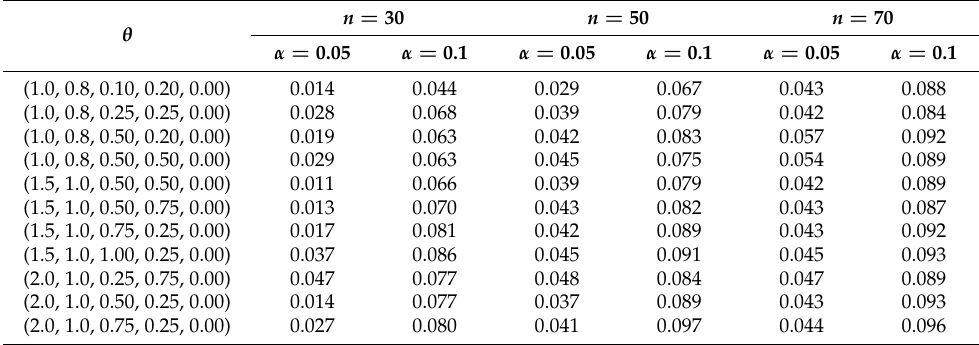
Table 3. Simulation results for the probability of type I error for a 1 = 0 and a 2 = 1.